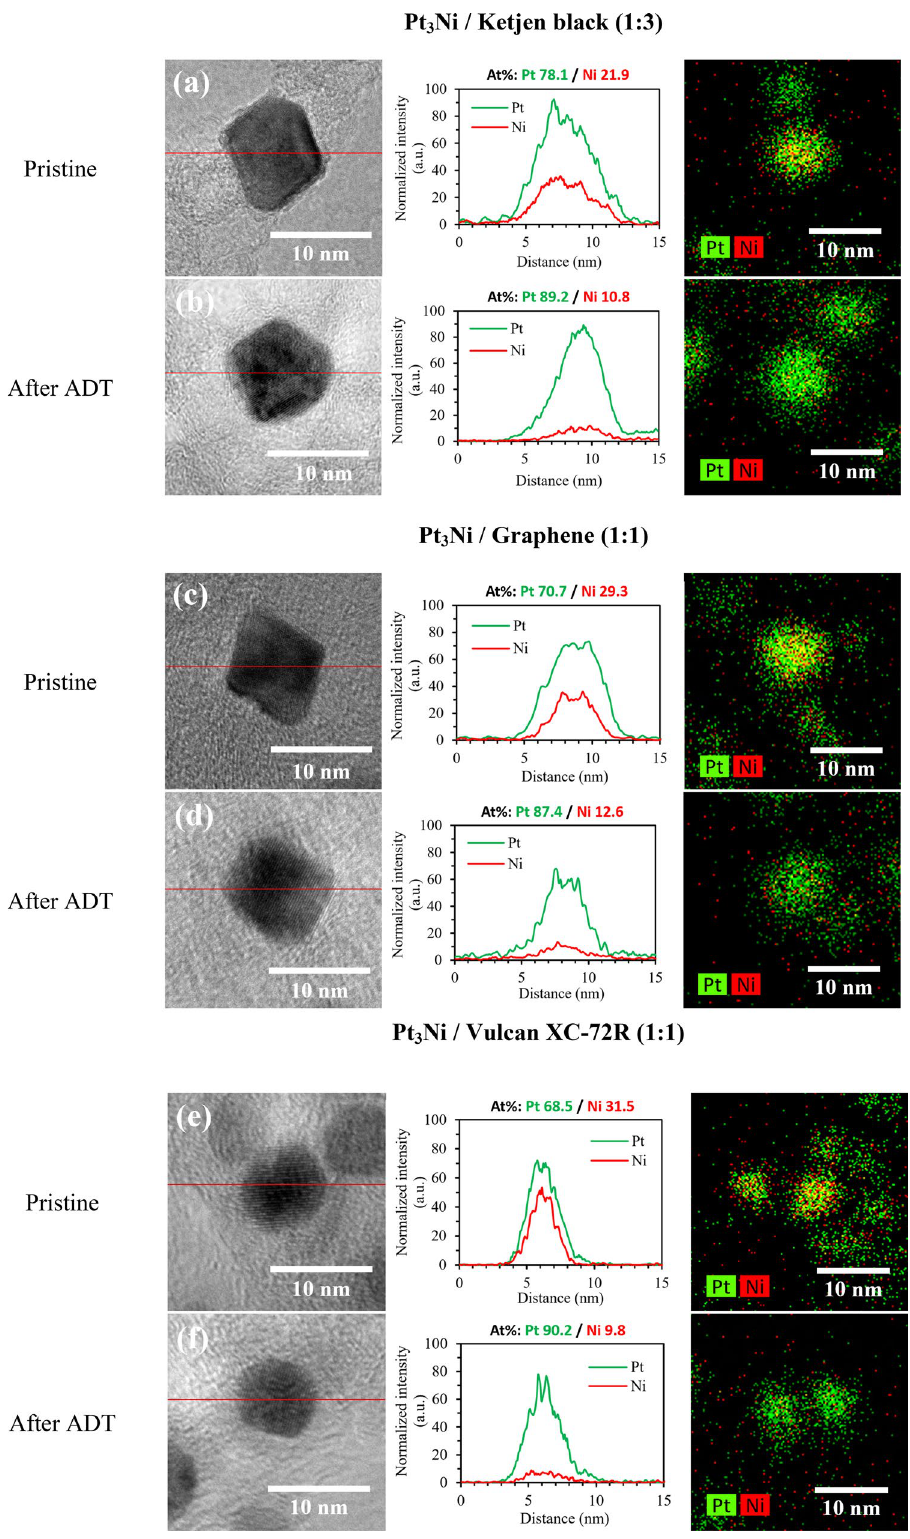
Figure 7. The TEM images, line scanning profile with EDX analysis, and spectroscopic mapping of Pt 3 Ni /C nanoparticles between pristine and after ADT samples; ( a , b ) Pt 3 Ni/Ketjen black (1:3); ( c , d ) Pt 3